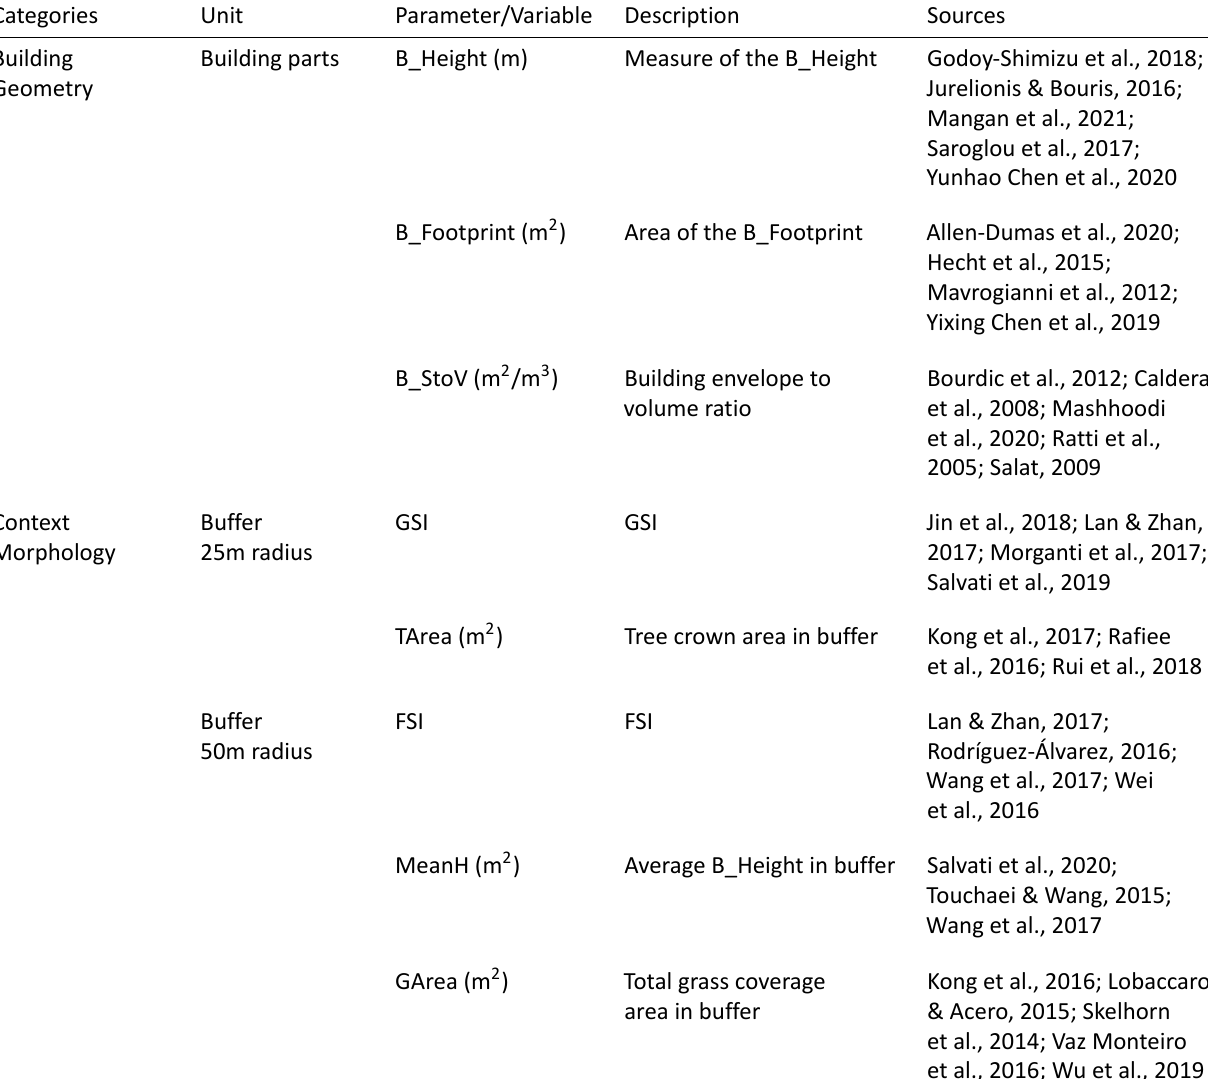
Table 1. Summary of the selected morphological